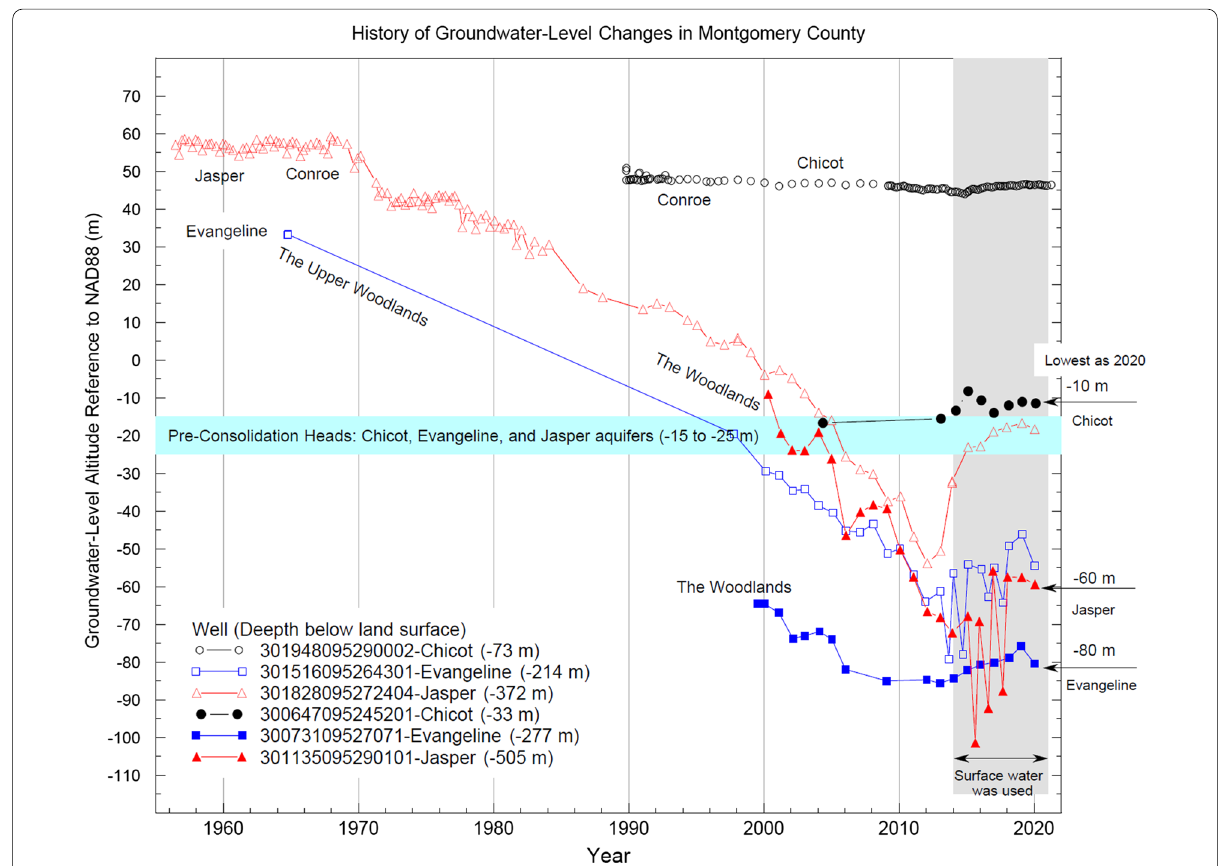
Fig. 7 The multi-decadal history of the Chicot, Evangeline, and Jasper groundwater levels in Montgomery County. Open symbols: groundwater-level changes at three long-history wells completed in the Chicot (1989–2020), Evangeline (1964–2020), and Jasper aquifers (1956–2020). Filled symbols: groundwater-level changes at three wells remaining the lowest altitude as of 2020 in the Chicot, Evangeline, and Jasper aquifers. Evangeline and Jasper groundwater levels began to rise in 2015 as a result of the reduction of